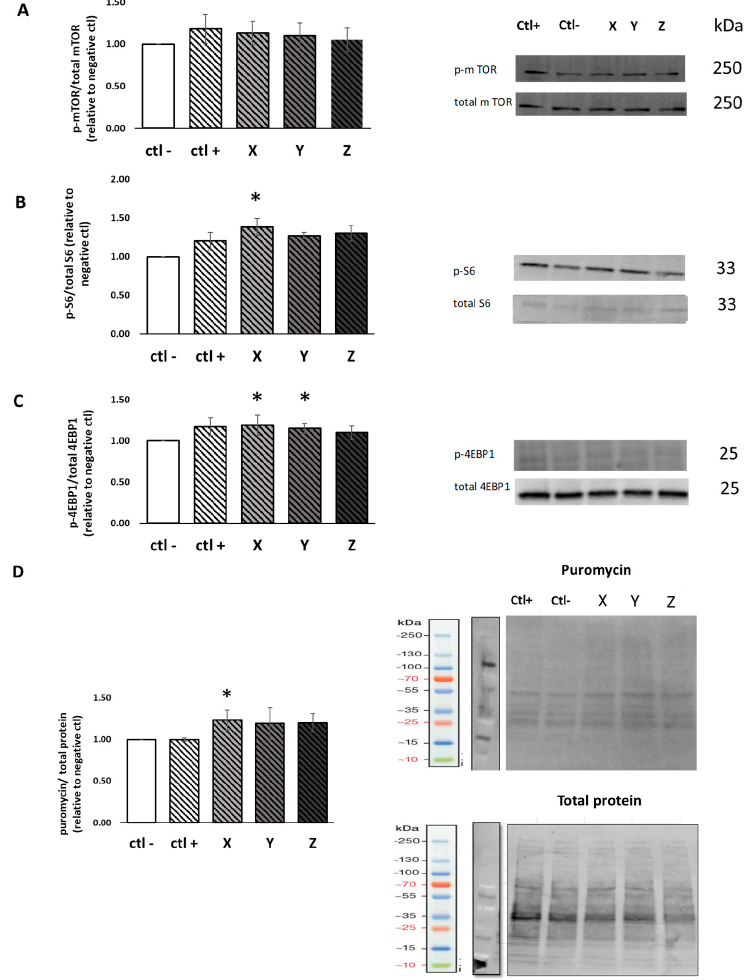
Figure 3. Phosphorylation of mTOR, 4EBP1 and ribosomal S6 incubated with 1 mg · mL − 1 protein equivalent BWPH-X, Y and Z (n = 4). C2C12 myotubes were nutrient deprived for 1 h followed by treatment with SGID-BWPHs plus 1 µM puromycin for 4 h. Data reported as the ratio of phosphoproteins relative to the total protein. All values were expressed as a percent of the negative control within each assay. Phosphorylation of mTOR ( A ), rpS6 ( B ) and 4EB-P1 ( C ) following SGID-BWPH treatment and their corresponding representative immunoblot. ( D ) Muscle protein synthesis (MPS) after treatment with SGID-BWPHs and their representative immunoblot of MPS (measured by puromycin incorporation) relative to total protein (loading control). Data reported as mean ± SEM, * compared to negative control, p < 0.01. Ctl − : negative control (amino acid and serum free media), Ctl+: positive control (100 ng·mL − 1 IGF-1), X: SGID-BWPH-X, Y: SGID-BWPH-Y, Z: SGID-BWPH-Z.